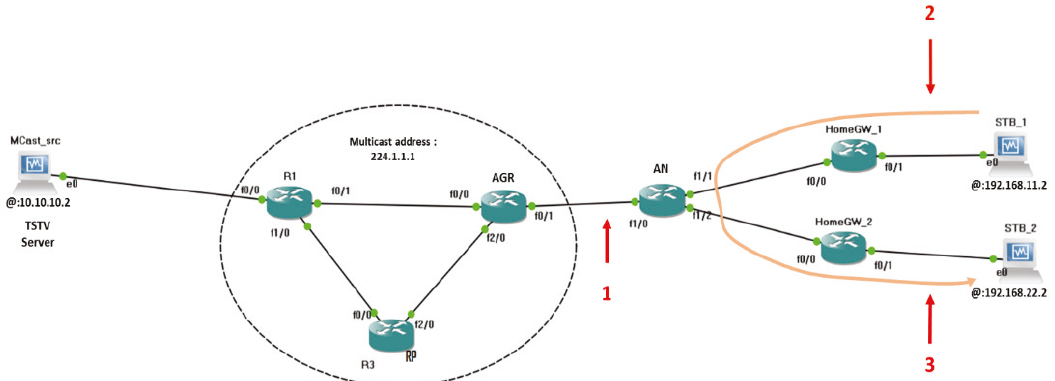
Figure 14: The proposed solution service